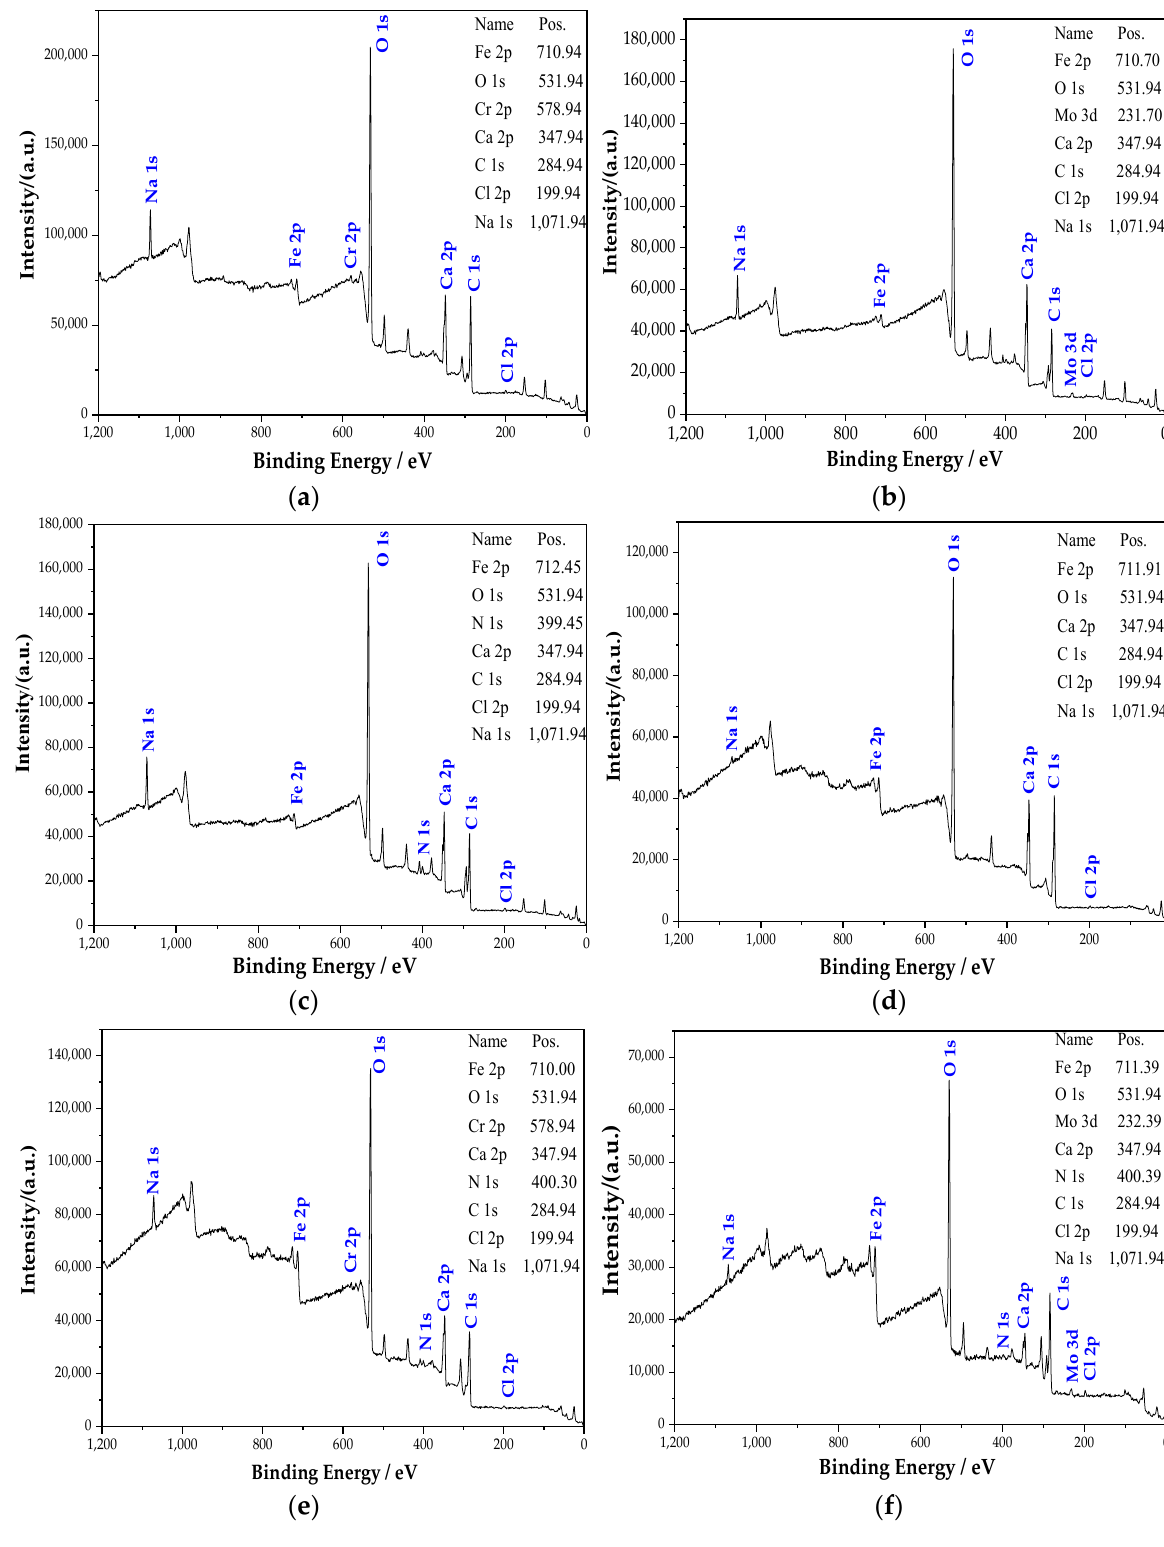
Figure 4. XPS full scan of the steel sample passive film in the different groups. ( a ) Na 2 CrO 4 group. ( b ) Na 2 MoO 4 group. ( c ) BTA group. ( d ) DMEA group. ( e ) Na 2 CrO 4 + BTA group. ( f ) Na 2 MoO 4 + BTA group.